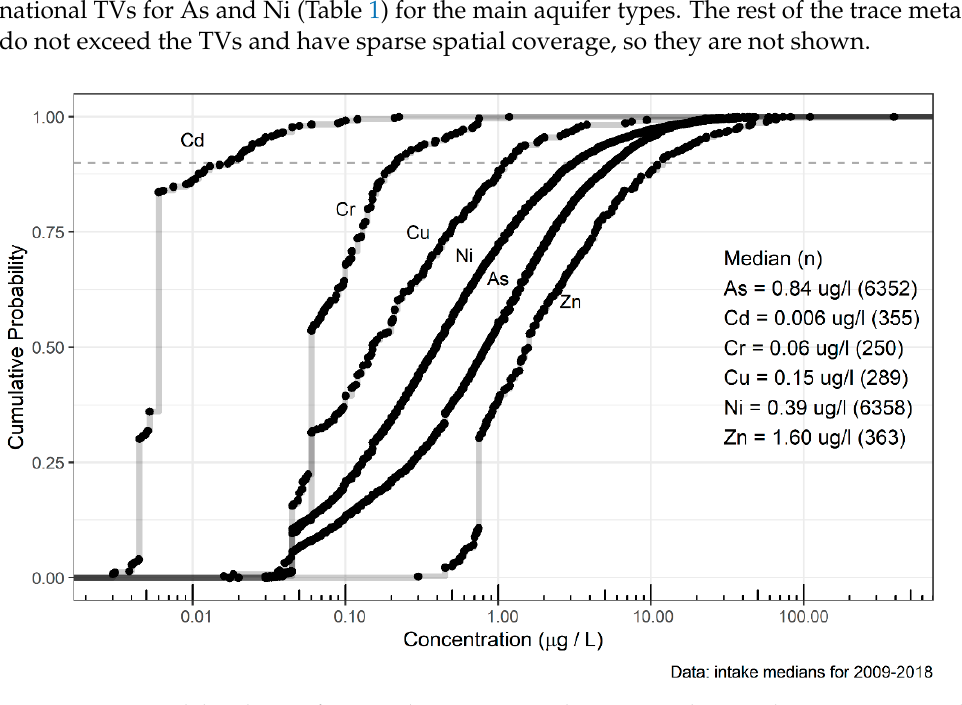
Figure 4. Spatial distribution of sampling points with As ( a ) and Ni ( b ) exceeding the national threshold values for As (5 µg/L) and Ni (10 µg/L). 4.2. Dataset Representativity The percent sampling points in the HOVER basis dataset falling in different aquifer types, pH and redox classes, and prevailing anthropogenic pressure are presented in Ta- ble A2. The dataset is biased toward Quaternary sand aquifers (53–64%) with neutral pH (53–57%), reduced conditions (76–83%), and agricultural pressures (75–86%) (Table A2). The bias toward agriculturally dominated locations is because of the high percentage of arable land in Denmark (61%). The waterworks wells are usually located in areas with only minor point-source pollution, as the Danish drinking water supply relies on clean groundwater, which is treated only with conventional systems (aeration and sand-